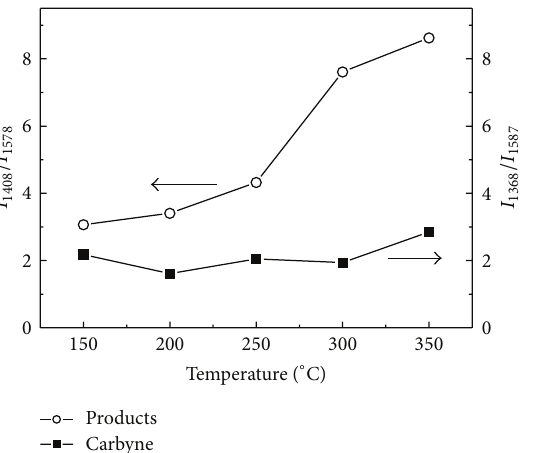
Figure 3: The intensity ratio between vibration modes of products and carbyne treated at different temperatures.